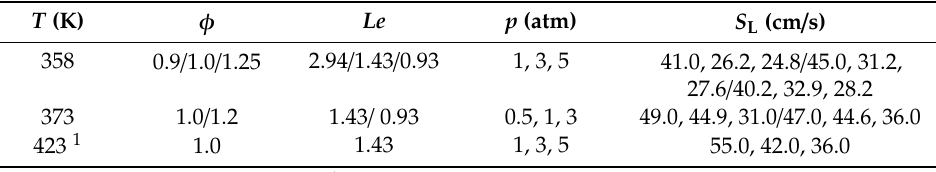
Table 1. Conditions and properties of iso-octane / air